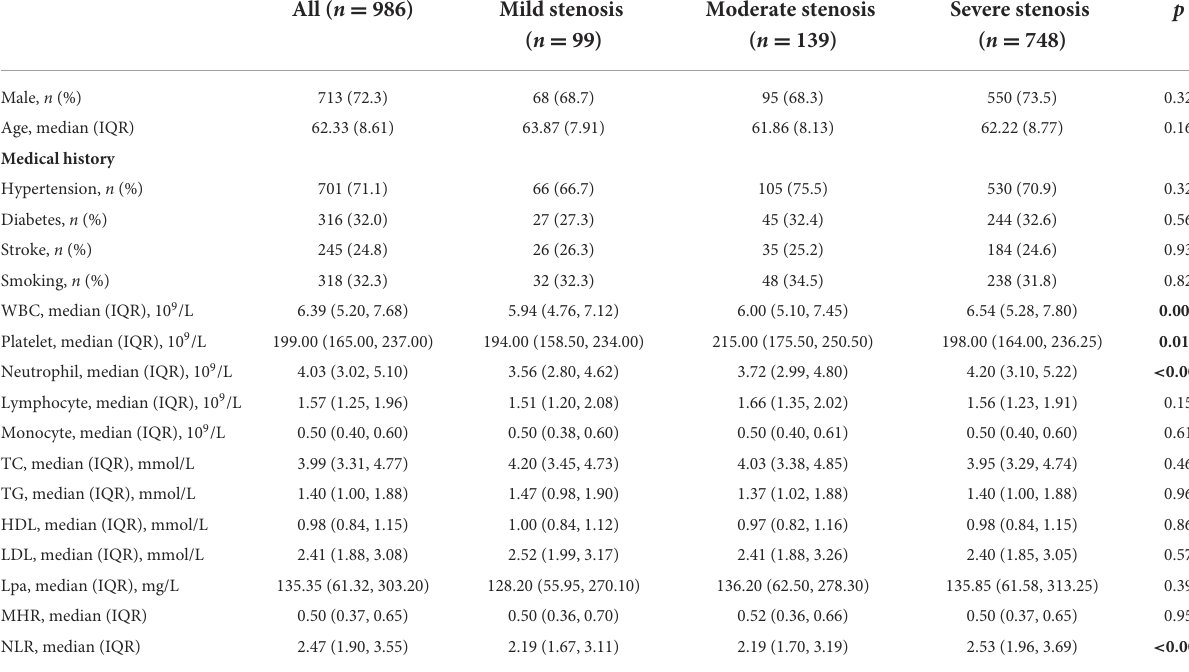
TABLE 5 Comparison of factors among patients in mild stenosis group, moderate stenosis group, and severe stenosis group. All ( n =